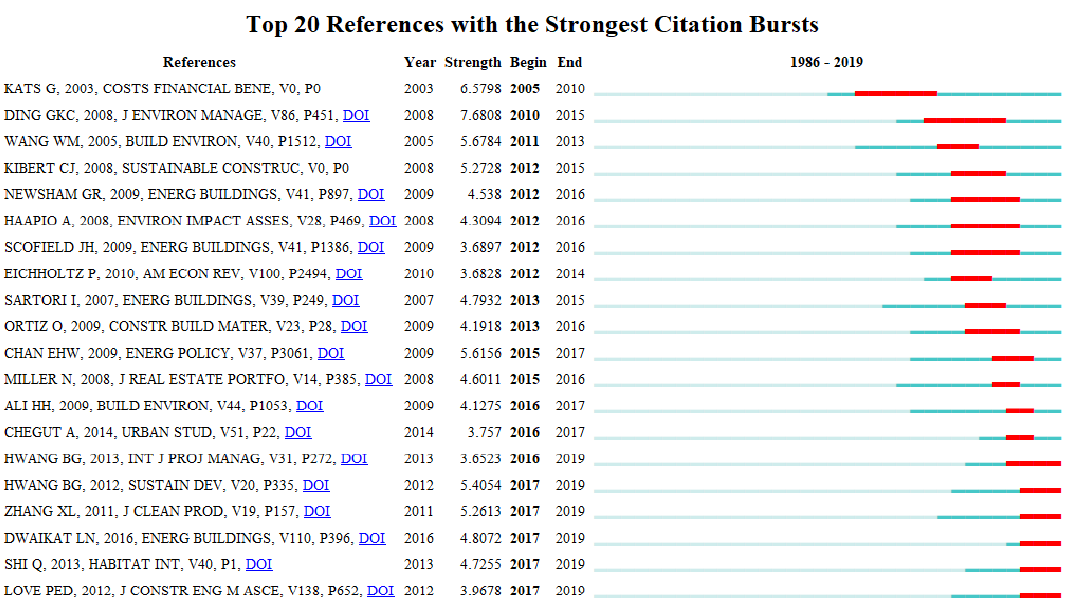
Figure 4. Top 25 keywords with strongest citation burst.